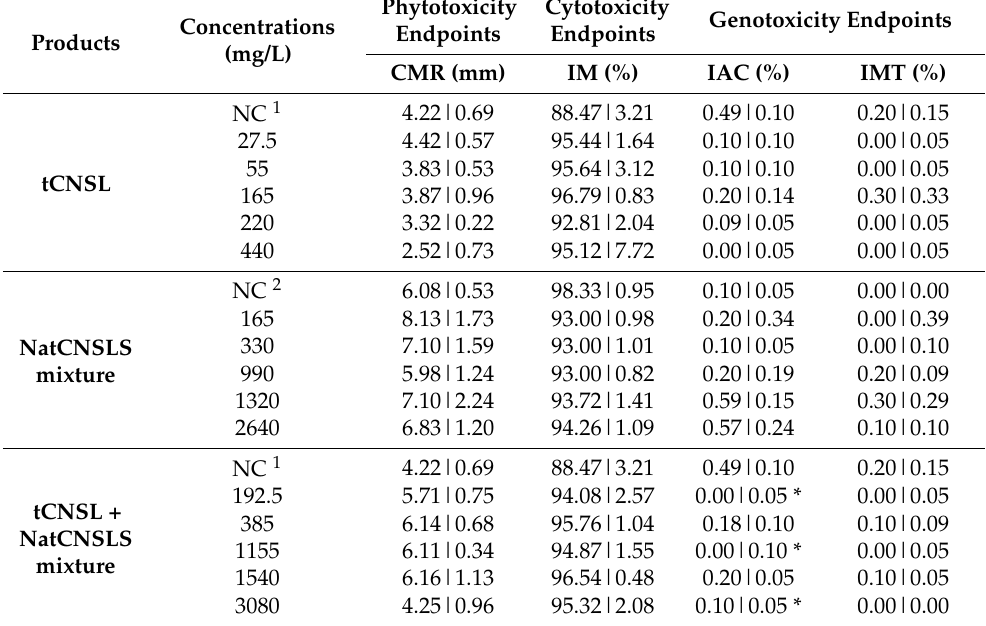
Table 3. Median and interquartile deviation from mean root length (CMR), mitotic index (IM), chromosomal alterations index (IAC) and mutagenicity index (IMT) obtained in tests with Allium cepa exposed to tCNSL + NatCNSLS mixture and its components (tCNSL and NatCNSLS mixture). Phytotoxicity Concentrations Endpoints Products (mg/L)